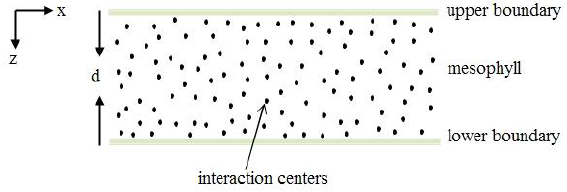
origin (Fig. 1). In vertical dimension, the z-axis is the normal of the leaf upper boundary pointing toward the inside of the leaf mesophyll. The upper boundary of the leaf is set equal to zero, and the lower boundary is set equal to d . Leaf’s lengths in x and y axes are 3 cm. When photon packet leaves the leaf from one side, it is supposed to enter the leaf from the opposite side with the same direction to simulate infinite extensions in horizontal direction.